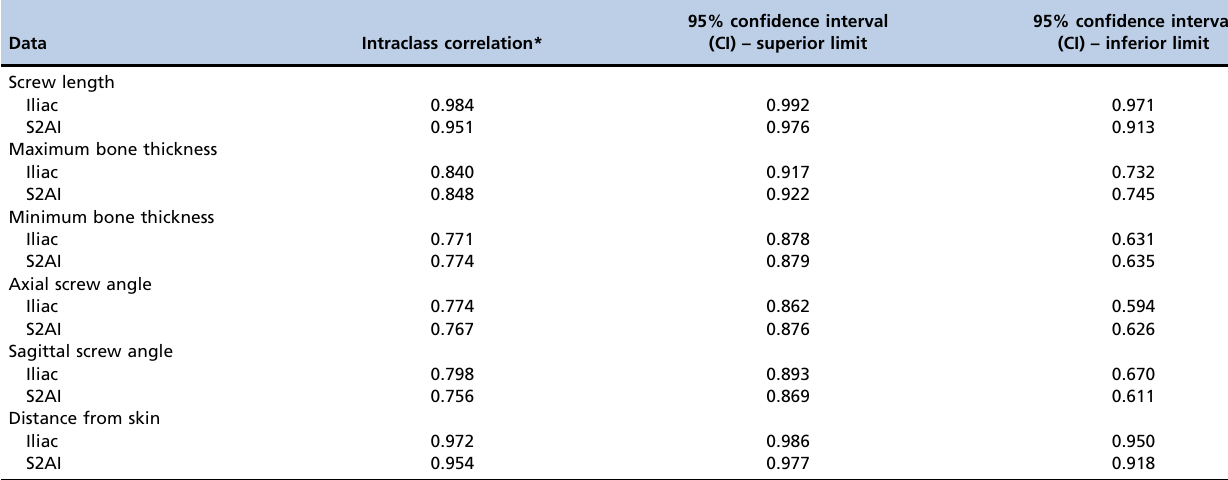
Table 2 - Comparison of the intraclass correlation coefficients.